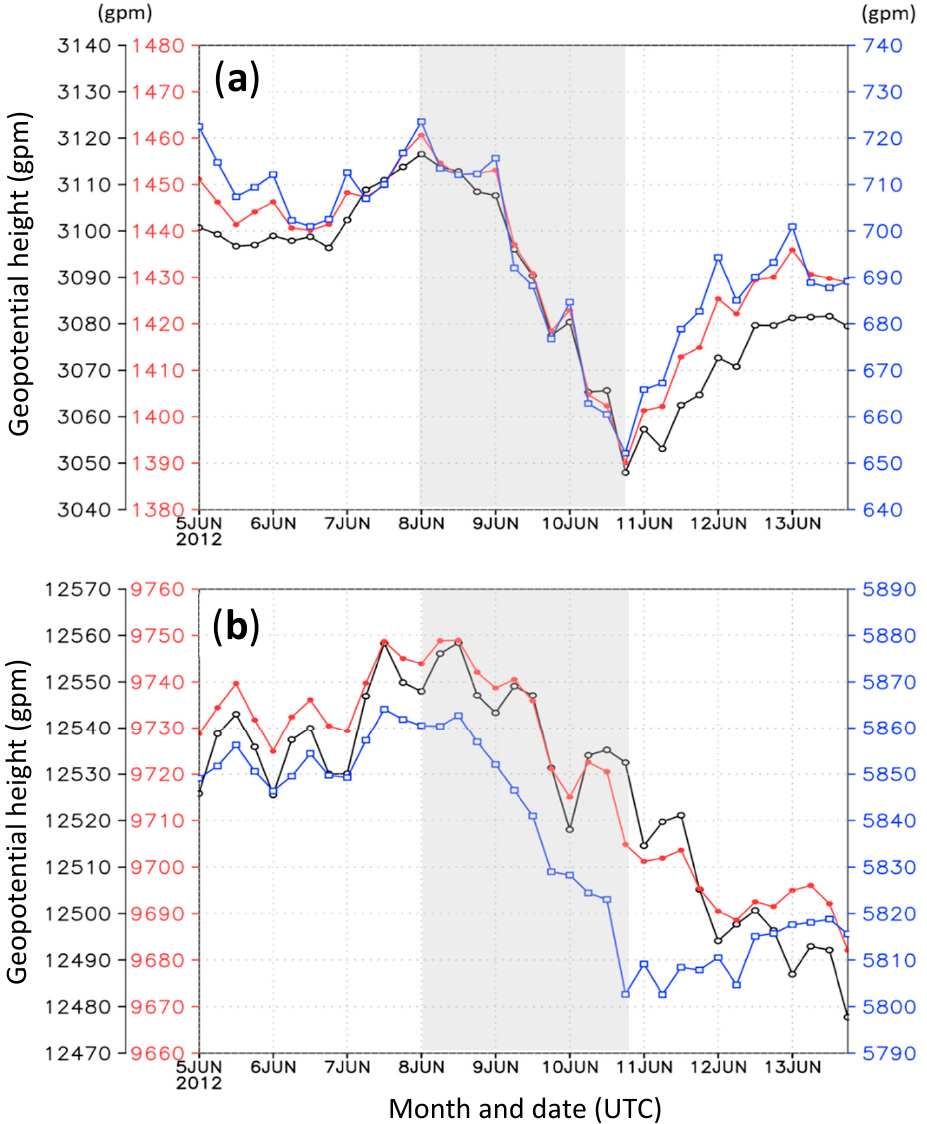
Figure 8. As in Figure 4, but showing the time series of geopotential height (gpm), averaged inside the red box in Figure 1 in South China at ( a ) 925 (blue), 850 (red), and 700 hPa (black), and ( b ) 500 (blue), 300 (red), and 200 hPa (black), from 0000 UTC 5 to 1800 UTC 13 June 2012. 8–10 June, the horizontal pressure (or height) gradients strengthened in northern SCS averaged over the region upstream from Taiwan (19 ◦ –22 ◦ N, 115 ◦ –119 ◦ E; blue box